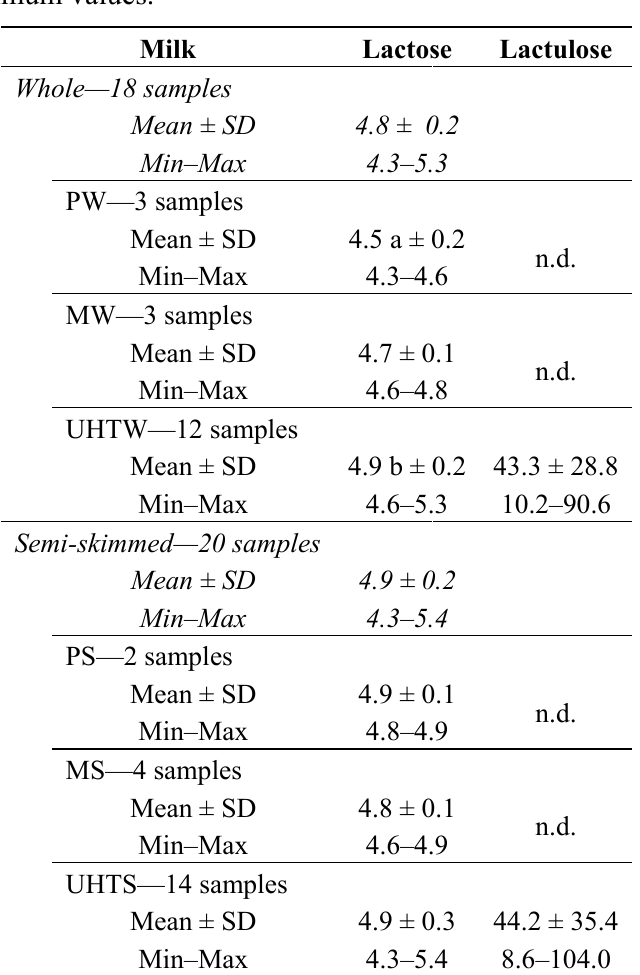
Table 2. Lactose (g/100 g) and lactulose (mg/100 g) in whole and semi-skimmed commercial Italian milk. Data are shown as the mean with standard deviation (SD) and minimum and maximum